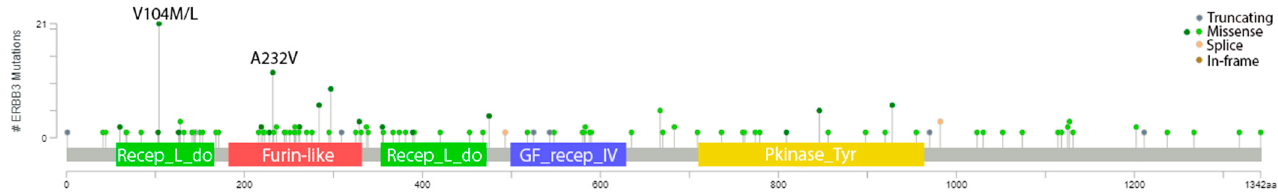
Figure 5. The frequency of HER3 mutations in colorectal cancer and their locations within the receptor. Figure rendered in cBioPortal using multiple studies (n = 4453). Gray indicates truncating mutation, green indicates a missense mutation, yellow indicates splice mutation, and brown indicates an in-frame mutation